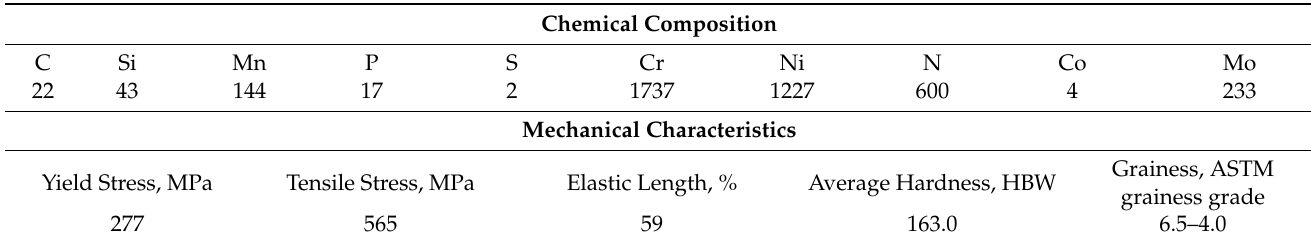
Table 1. Specifications of the plain plate samples.